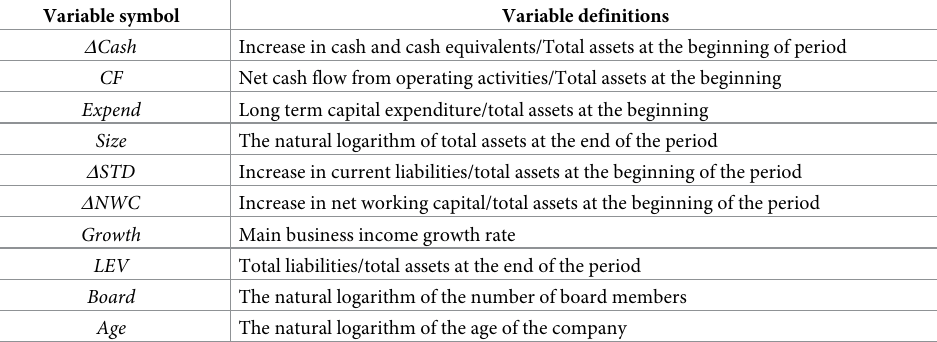
Table 9. Description of the main